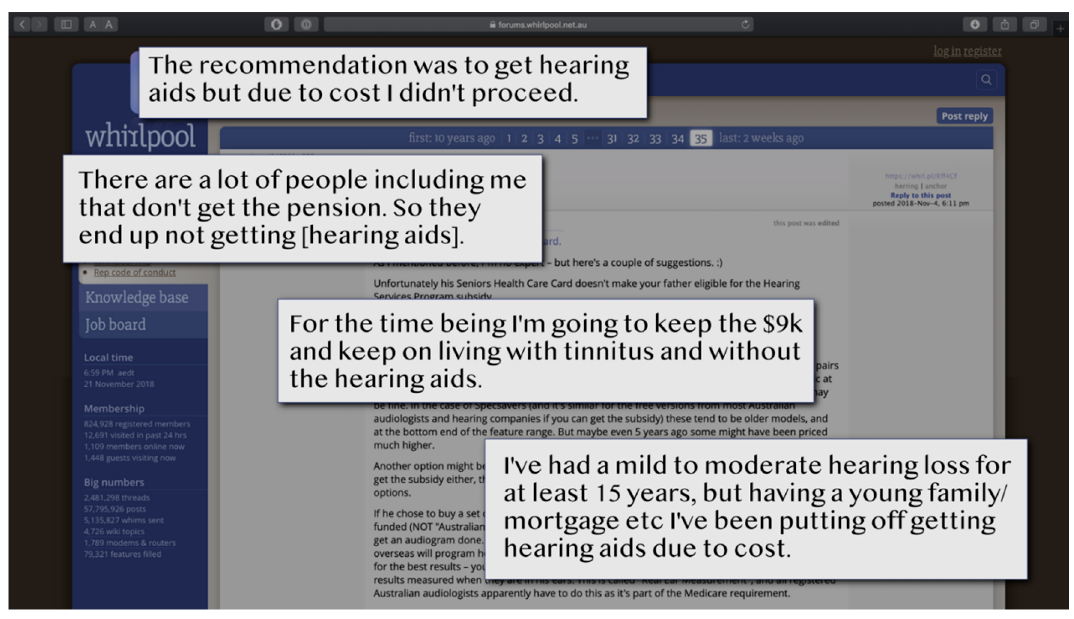
Figure 2. Internet forum thread regarding access to hearing aids.